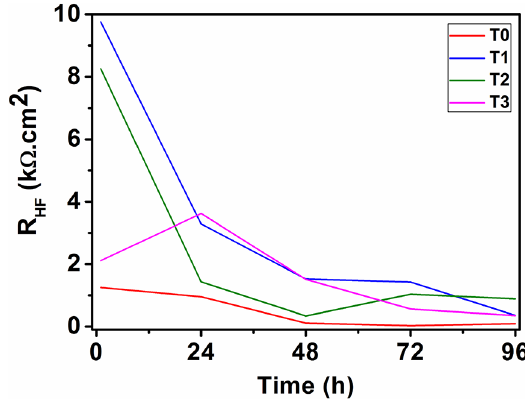
Figure 10. Evolution of the resistance of hybrid coatings for the samples, in relation to the immersion time, in a 0.05 mol.L –1 NaCl solution.